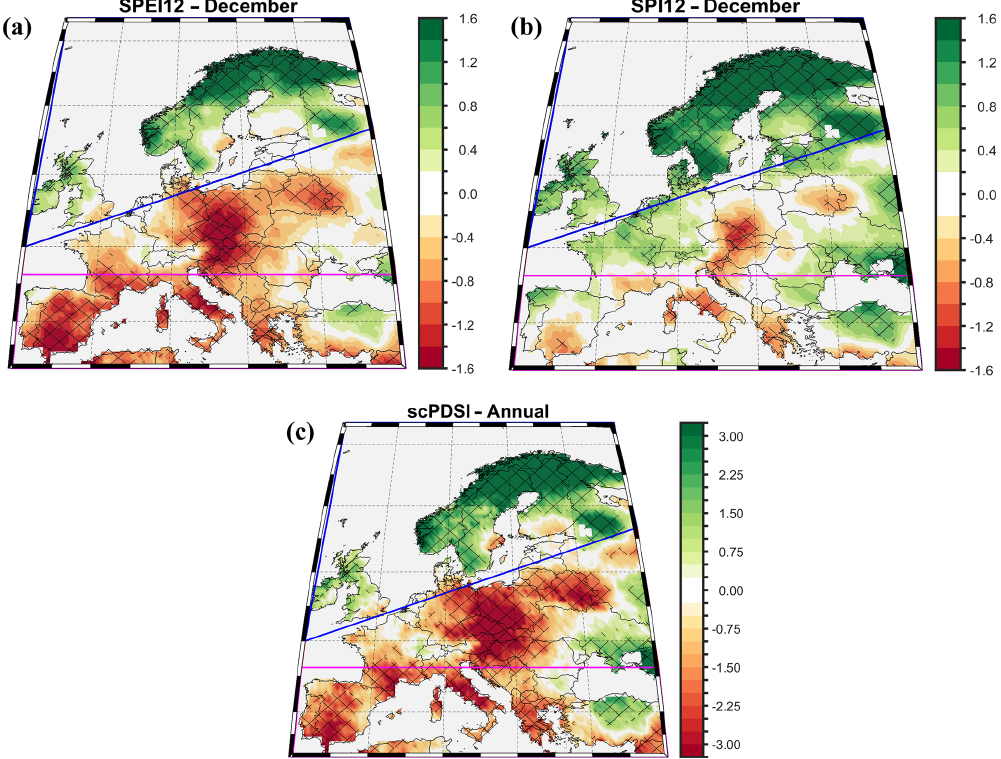
Figure 1. (a) Linear trend of the December SPEI12; (b) as in (a) but for the SPI12, and (c) as in (a) but for the annual scPDSI. Stipples indicate statistically significant trends (99% confidence level). Analyzed period: 1902–2019. Units: z scores/118